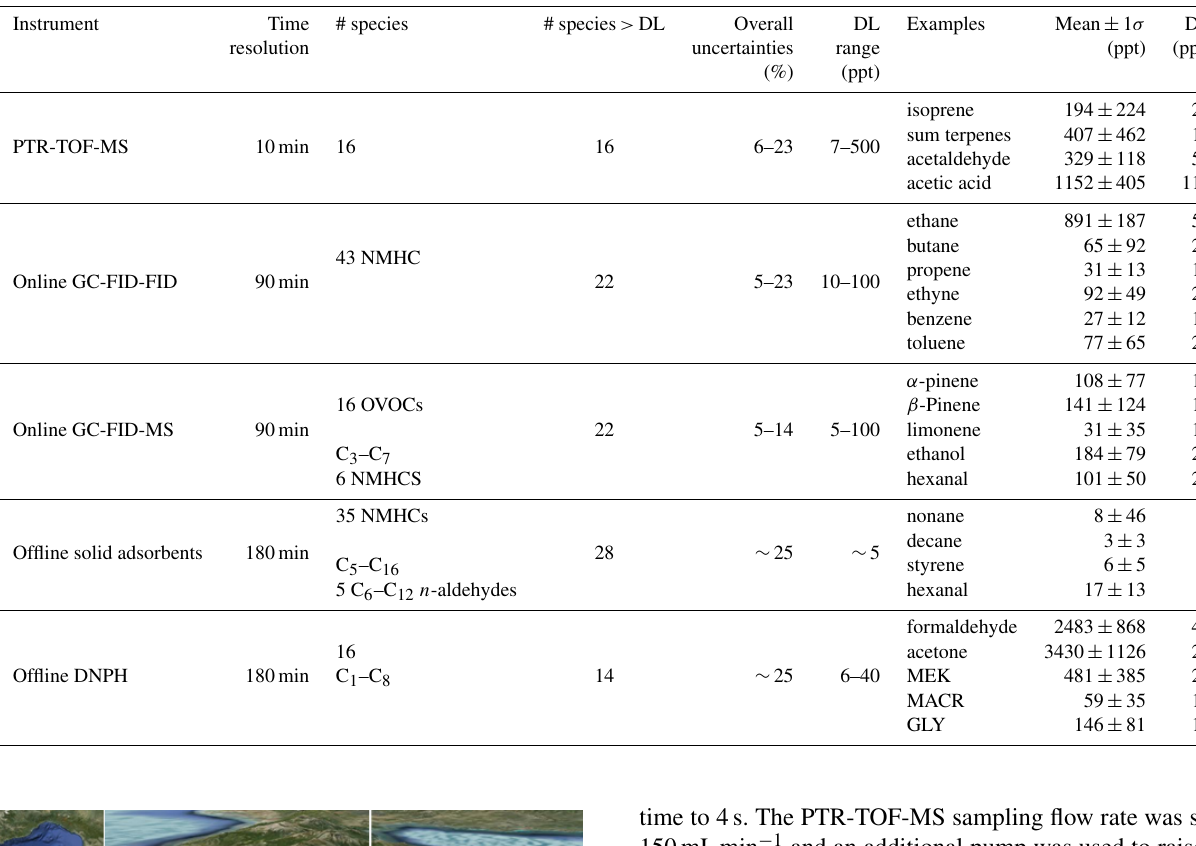
Table 1. Summary of VOC measurements performed at Cape Corse during the ChArMEx SOP2 field campaign. DL is detection limit. Instrument